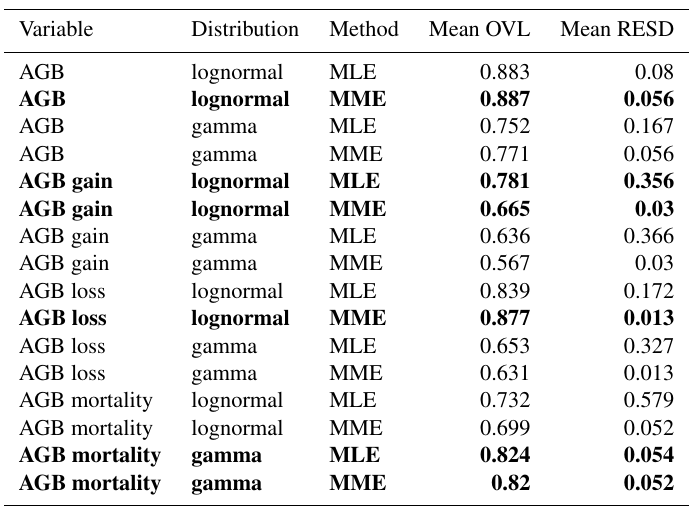
Figure 5. Downscaling the aboveground biomass distribution from the 100m scale to three other scales. Black curves represent the down- scaled (down) lognormal probability density functions and grey histograms the empirical (emp) distributions from the field. Standard devia- tions are given for each distribution. Table 2. Goodness-of-fit criteria values for the different distribution functions and fitting methods for all four variables. Best-matching distributions, i.e., those with the largest mean overlap (OVL) and smallest mean relative error of standard deviation (RESD), are highlighted in bold font. Mean hereby refers to the mean over all four spatial scales (10, 20, 50,